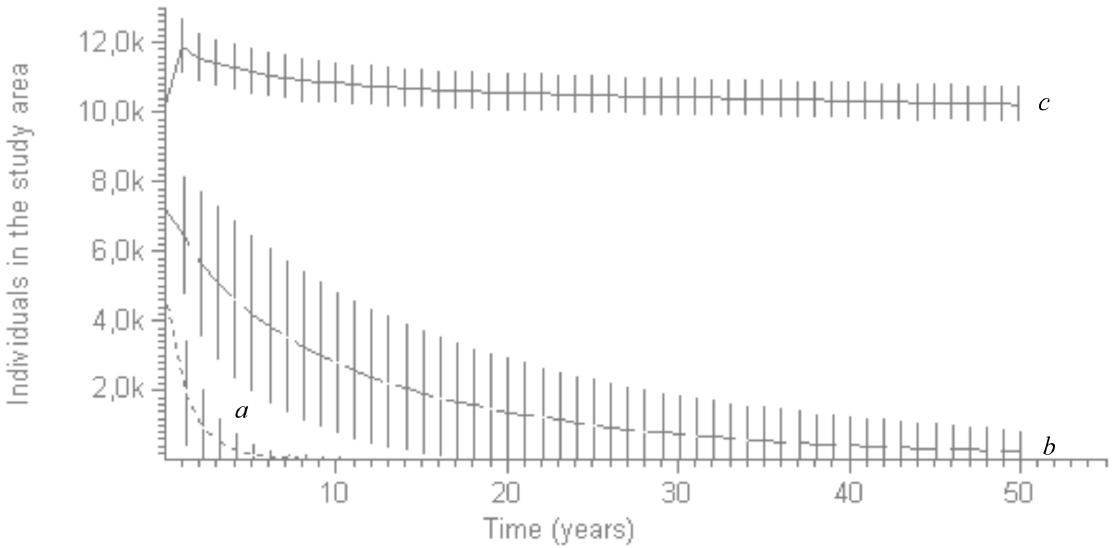
Fig. 4. Trends in abundance of the great crested newt in the study area during 50 years under different scenarios: a) minimum estimates of uncertain parameters; b) medium estimates; c) maximum estimates. Solid curves show the average abundance and vertical bars show ± 1